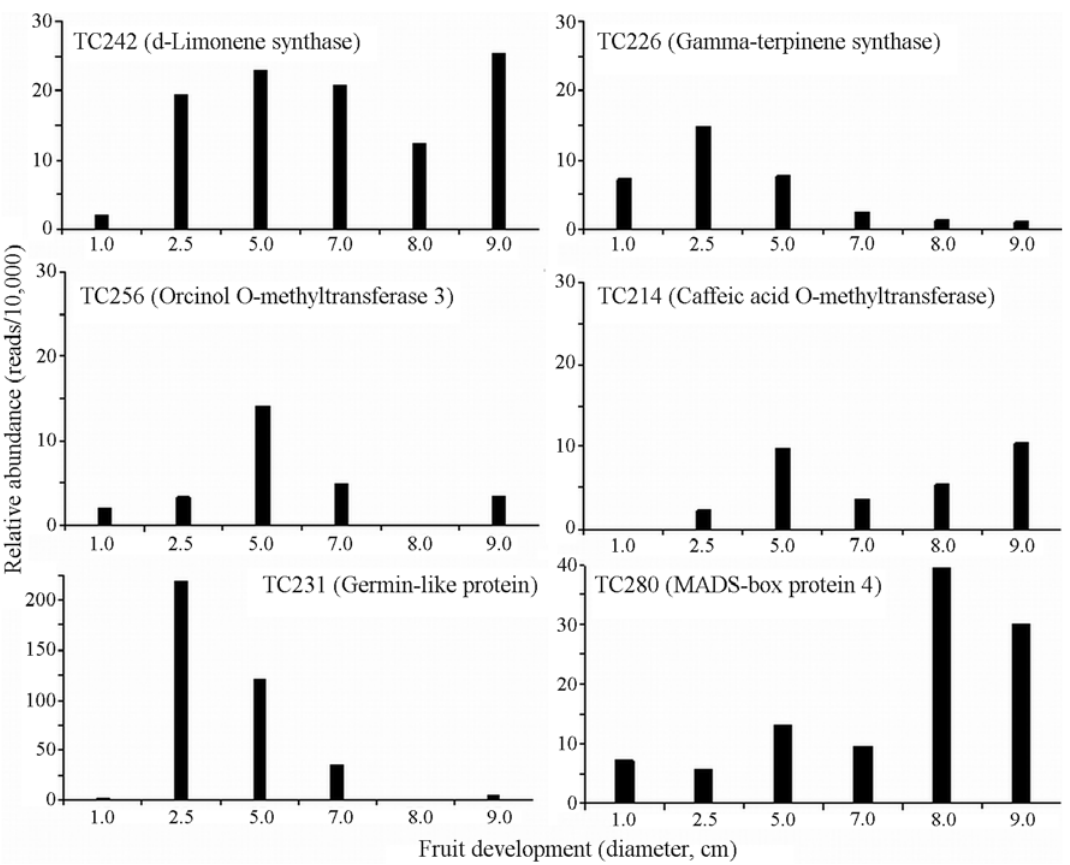
Figure 3 - Relative abundance (reads per 10,000 reads library) and expression pattern of the flavedo tentative consensi: TC242 (d-Limonene synthase), TC226 (Gamma-terpinene synthase), TC256 (Orcinol O-methyltransferase 3), TC214 (Caffeic acid O-methyltransferase), TC231 (Germin-like protein) and TC280 (MADS-box protein 4) throughout fruit development (from 1 cm to 9 cm fruit